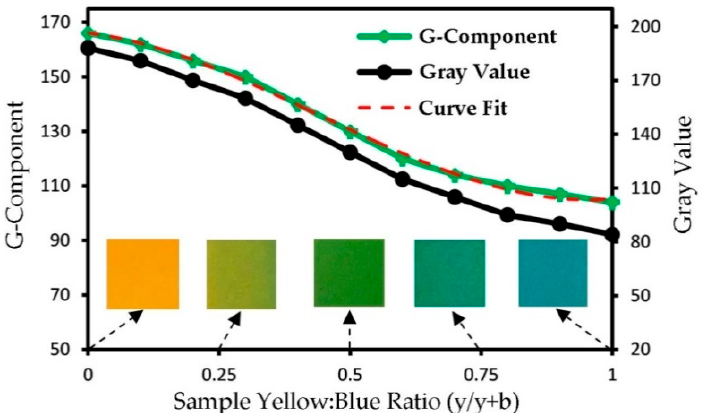
Figure 3. Calibration of the green component and equivalent gray value for different sample concentration ratios (yellow to blue dye). Images of five ratios (from pure yellow to pure blue) are illustrated on the chart. A curve was fitted to find a practical correlation, used during the image-based MI assessment.